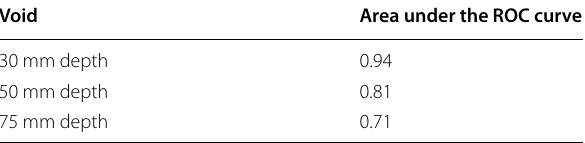
Table 2 Area under the ROC curve for void type